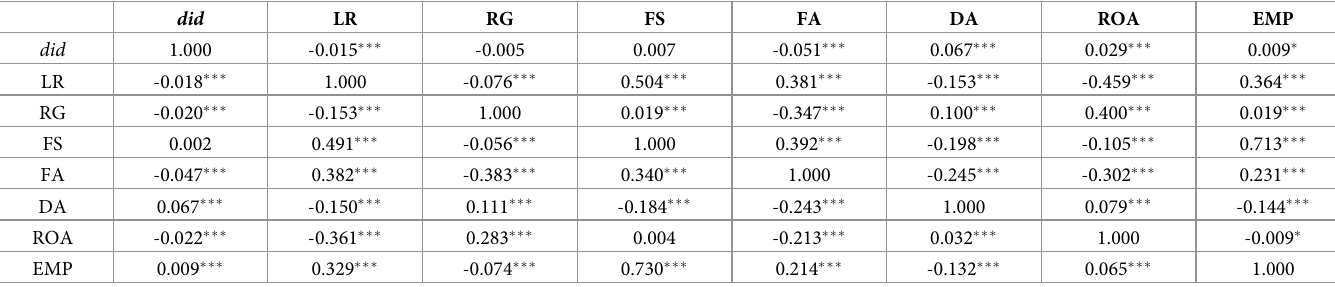
Table 2. Correlation coefficient